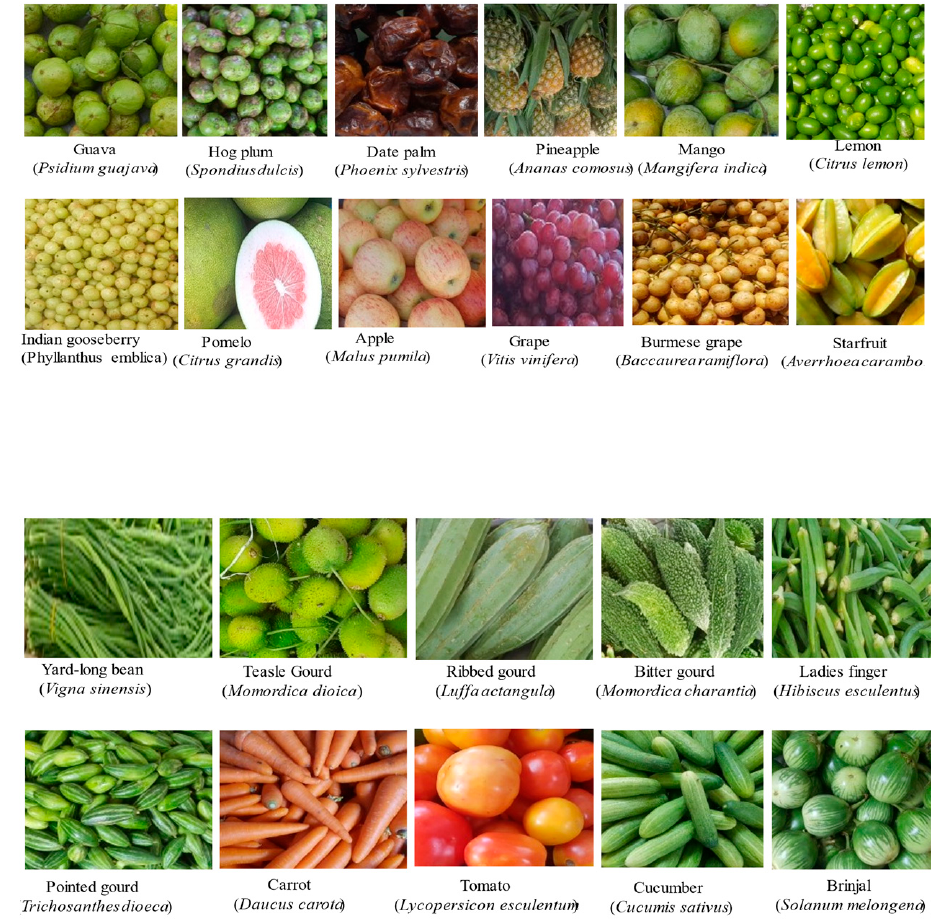
Figure 1. Fruit and vegetables collected from four different locations in Dhaka City. One milliliter of initial dilution (1:10) was transferred to the 9 mL tube of Ringer solution, which was prepared for 10 − 2 dilution for the enumeration of Staphylococcus spp. and Pseudomonas spp. The dilution was prepared until 10 − 6 in this way. One millilter of suspension was transferred for each decimal dilution for the isolation and detection of Staphylococci spp. to the selective Staphylococcus medium (Himedia, Mumbai, India) [40]. Pseudomonas agar medium (Himedia, Mumbai, India) was thus used for the identification of Pseudomonas species that displayed blue-green or brown pigmentation on medium after incubation for 24–48 h at 37 ◦ C